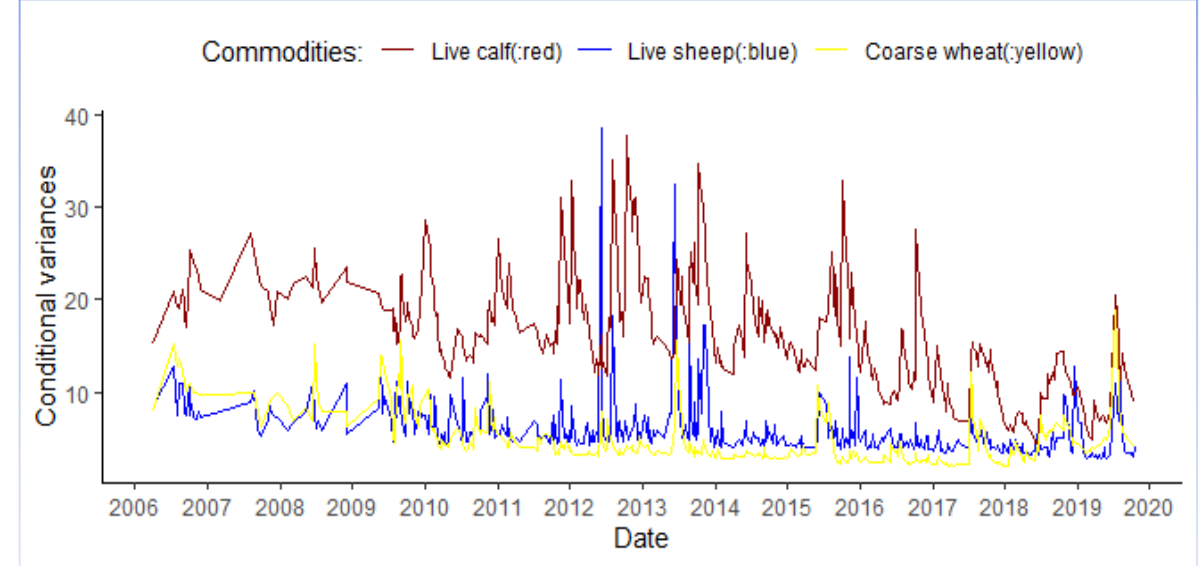
Figure 4. Time-varying conditional variances of live calves, live sheep, and coarse wheat.